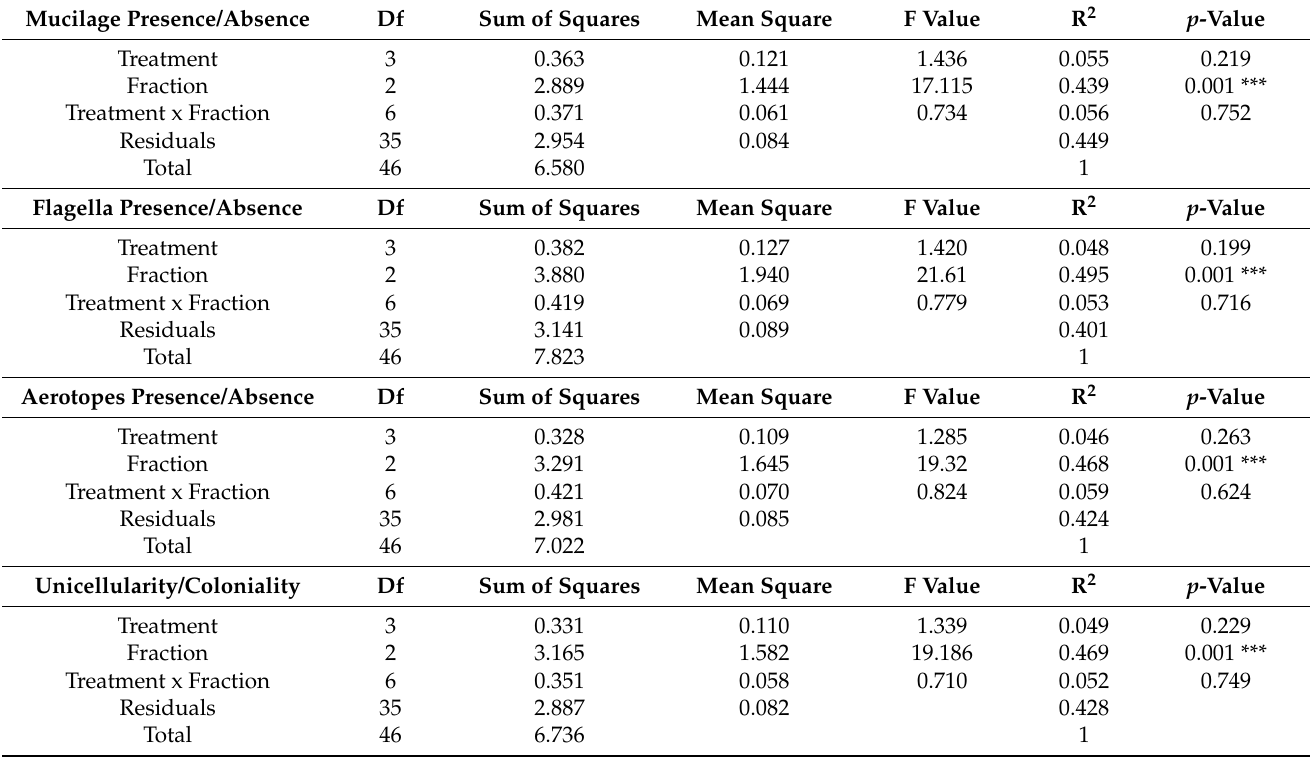
Table 1. Results of permANOVA analysis conducted on phytoplankton traits abundance. Variances among traits were analyzed in the different treatments (starting condition, control and grazing treatments), in all phytoplankton size fractions (<5 µ m, 5–30 µ m and >30 µ m). Asterisks indicate statistically significant